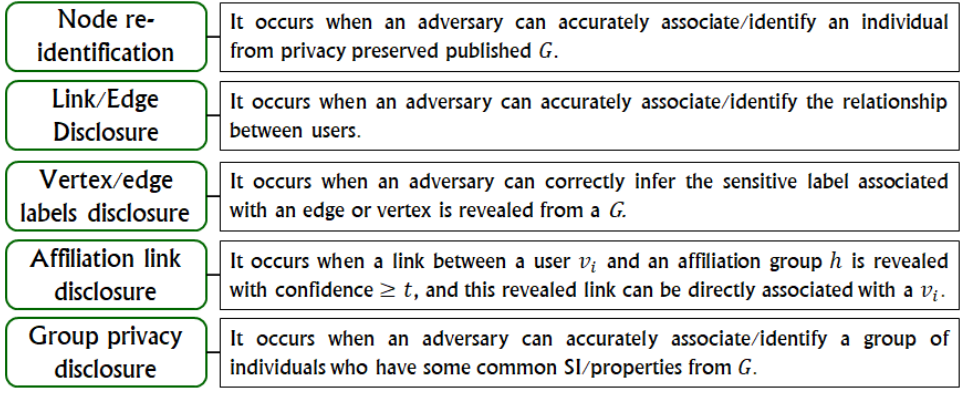
Figure 6. Five famous and practical privacy threats that can occur in publishing G with researchers.